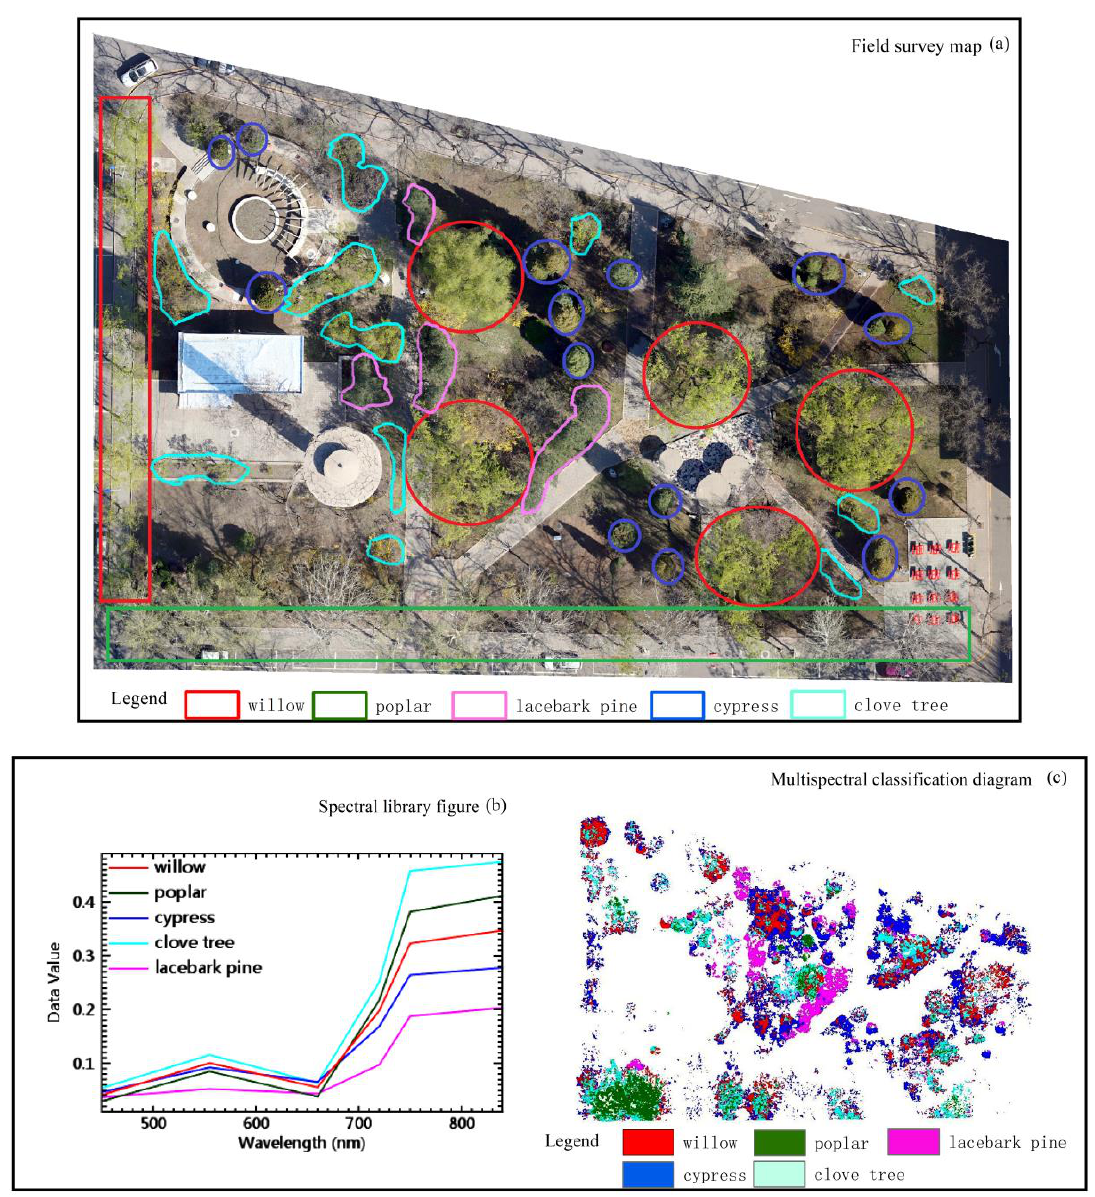
Figure 4. ( a ) Field survey map, ( b ) spectral library spectra, and ( c ) multispectral classification diagram.